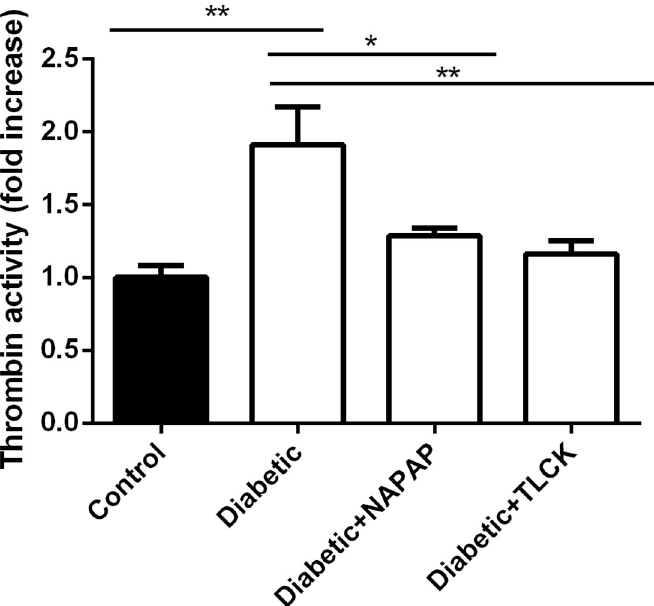
Fig 1. Thrombin activity is increased in diabetic sciatic nerve. An ex-vivo experiment in which thrombin inhibitors were added to the test wells. Control column includes healthy rats treated with saline, TLCK and NAPAP. Data are represented in comparison to measured thrombin activity in control column, which was defined as 1. Thrombin activity was significantly elevated in diabetic rats compared to control. Thrombin activity measured in the sciatic of the diabetic rats was significantly inhibited by in-vitro addition of NAPAP and TLCK compared to untreated diabetic rats. Data are represented as mean ± SEM. � p � 0.05, �� p � 0.01. Number of samples: control-saline (n = 3), control-NAPAP (n = 3), control-TLCK (n = 3), diabetic-saline (n = 3), diabetic-NAPAP (n = 3), diabetic-TLCK (n = 3).